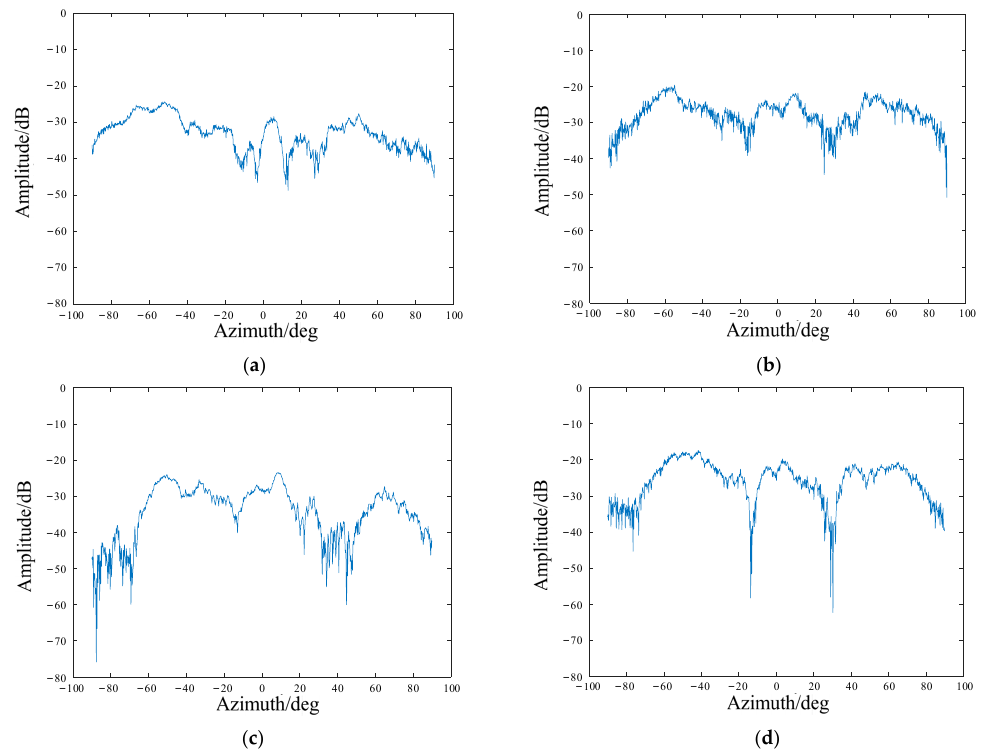
Figure 4. Random radiation field patterns at different frequencies. ( a ) 32.00 GHz; ( b ) 32.99 GHz; ( c ) 34.01 GHz; ( d ) 35.00 GHz.